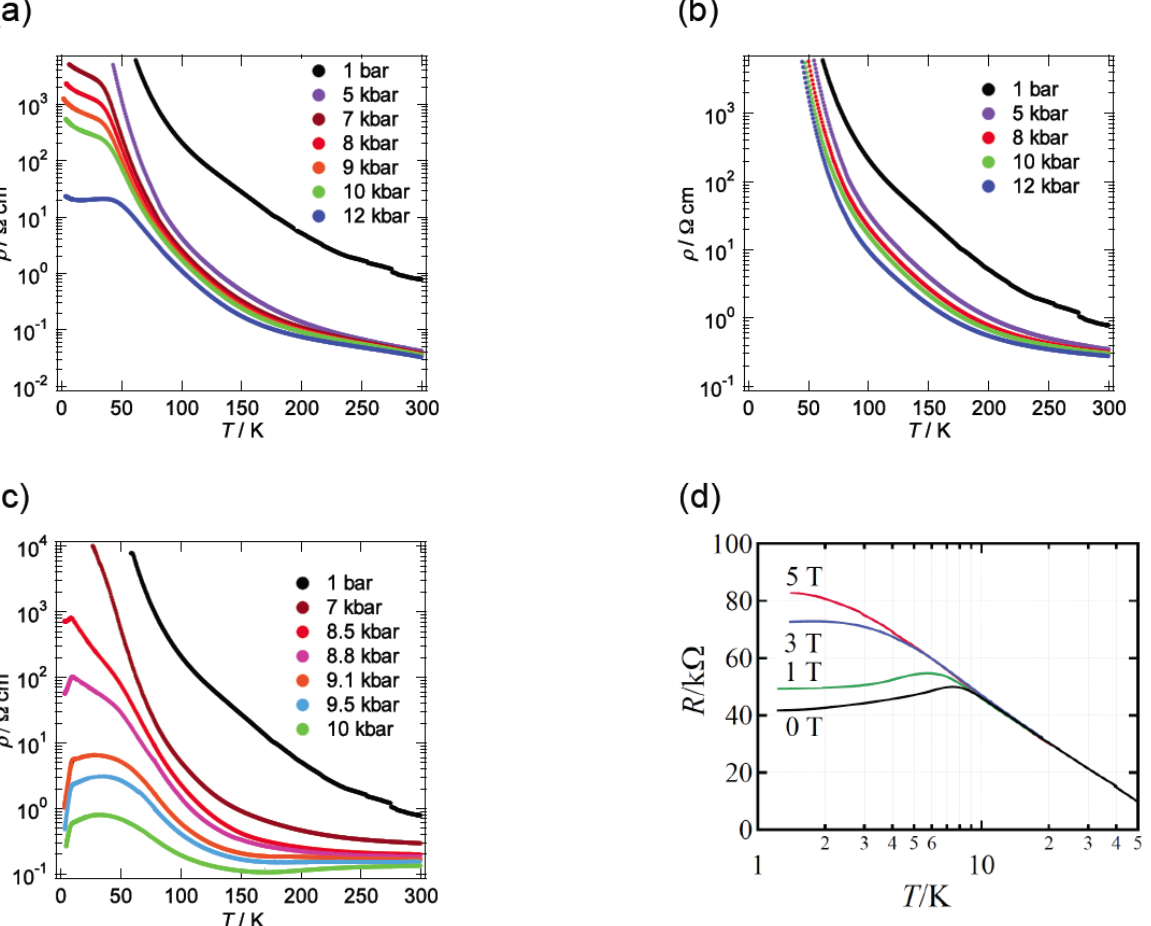
Figure 9. Temperature dependence of the resistivity of β-(BDA-TTP) ( a ) a -axis, ( b ) b -axis and ( c ) c -axis strains. ( d ) Magnetic-field dependence of the resistivity drop in β-(BDA-TTP) I under a uniaxial strain of 10 kbar with φ = ~7°. The magnetic 2 3 field was applied along the crystallographic b -axis (Reprinted with permission